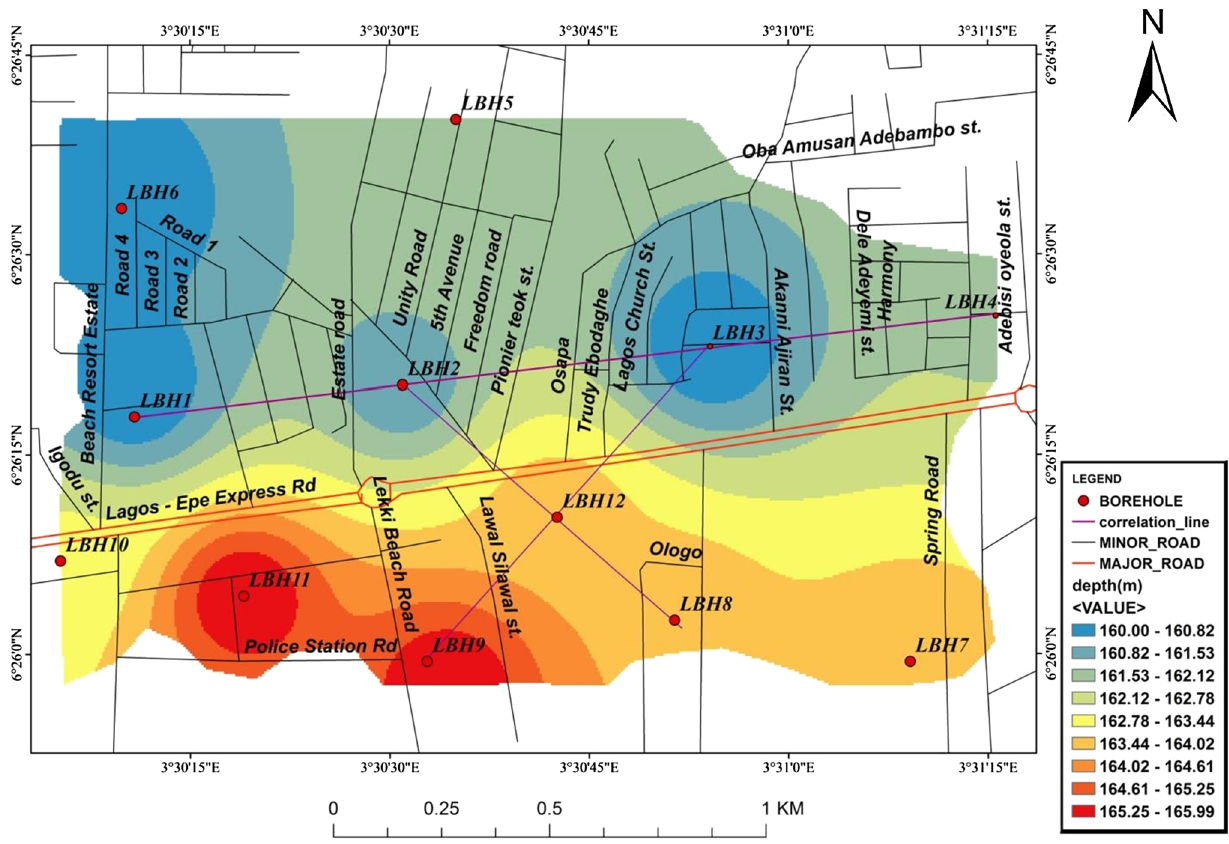
Fig. 11 Isopach map showing the depth extent of the polluted zone of Lekki